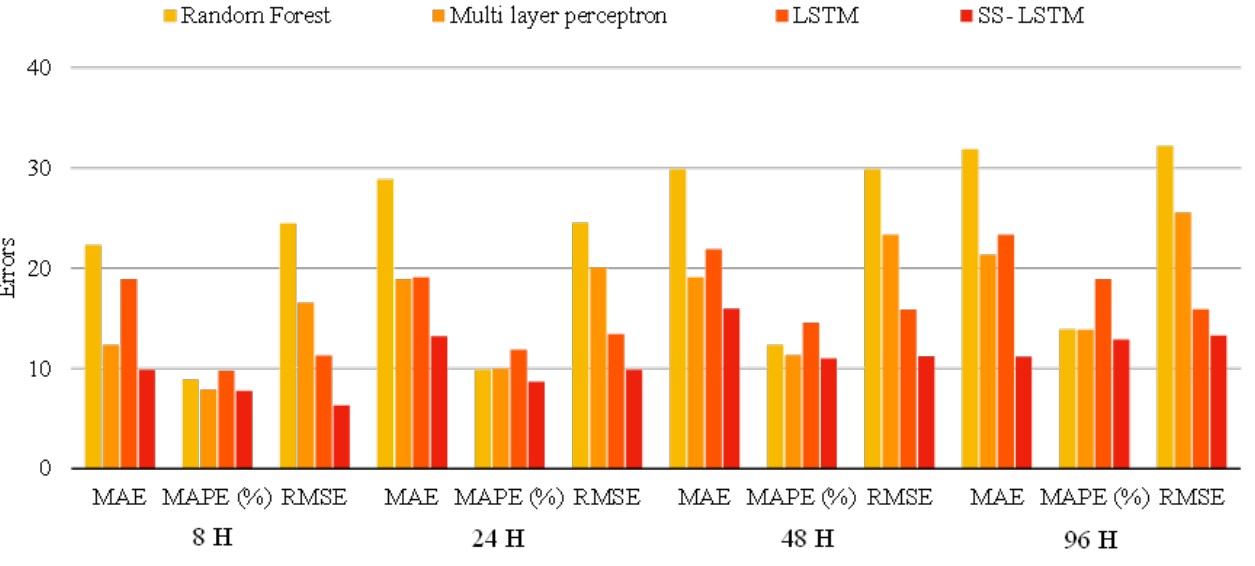
Figure 5. Comparison between the errors with respect to the PM10 forecast.